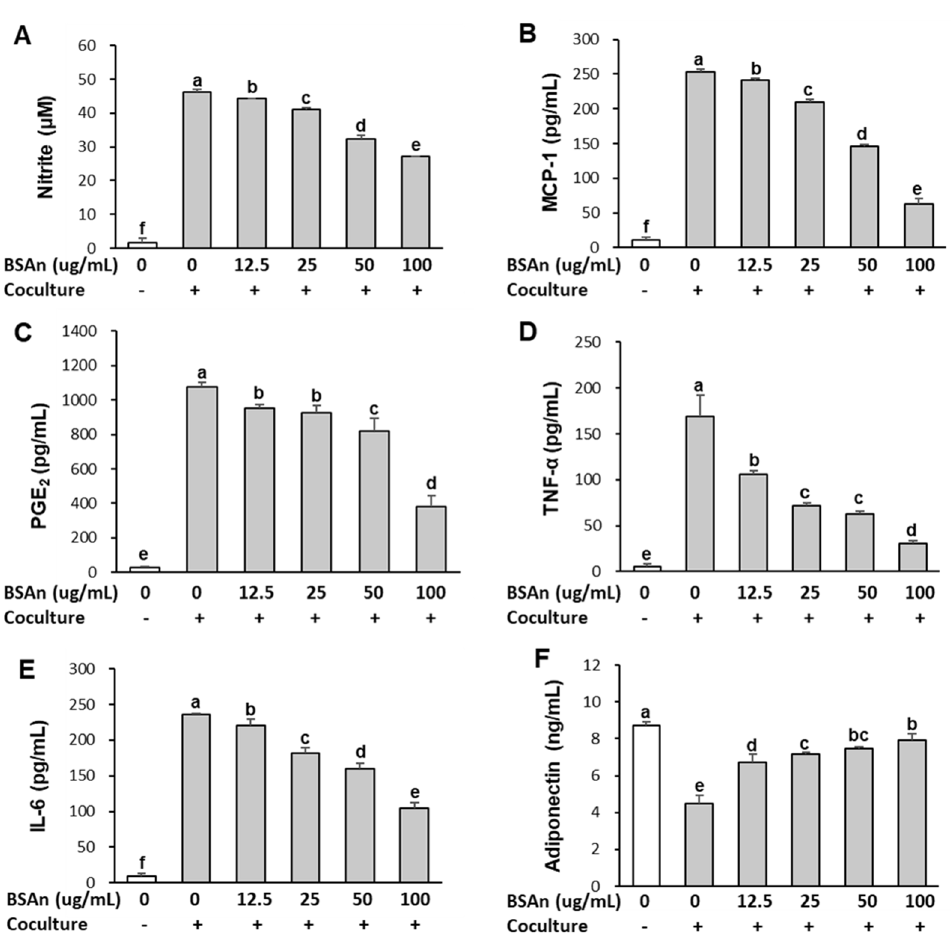
Figure 3. Effect of black soybean anthocyanin extract (BSAn) on the inflammatory response in the coculture of adipocytes and macrophages. Hypertrophied 3T3-L1 adipocytes were cocultured with RAW264.7 macrophages for 24 h and then treated with BSAn for 24 h in the contact system. The concentration of NO ( A ), MCP-1 ( B ), PGE 2 ( C ), TNF α ( D ), IL-6 ( E ), and adiponectin ( F ) were measured in the coculture media by ELISA. Data are presented as mean ± SD of three independent experiments. a,b,c,d,e,f Means without the same letter are significantly different by ANOVA, followed by Duncan’s test ( p < 0.001). +: adipocytes were cocultured with macrophages, -: adipocytes and macrophages were separately cultured and